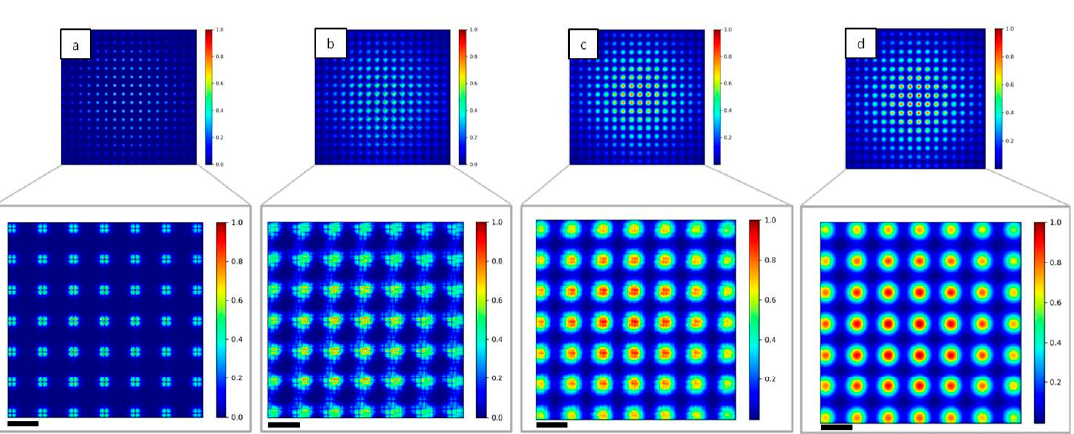
Figure 7. 2D intensity maps of the simulated Hartmann mask imaged at the detector plane for di ff erent values of N . ( a ) N = 1, ( b ) N = 10, ( c ) N = 100 and ( d ) N = 1000. The di ff raction pattern created with coherent illumination ( a ) will become more noisy increasing N , reaching a Gaussian shape in the incoherent case ( d ). Insets show a magnification of the central part of the mask. Scale bars are 16 µ m.